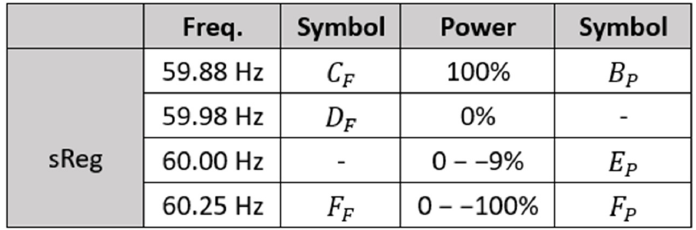
Figure 2. The response table of the dReg mode.